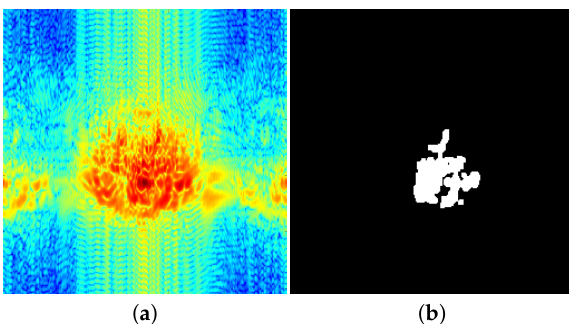
Figure 23. Misclassified image of a set of keys: ( a ) RGB mmW scan; ( b ) Segmented image.